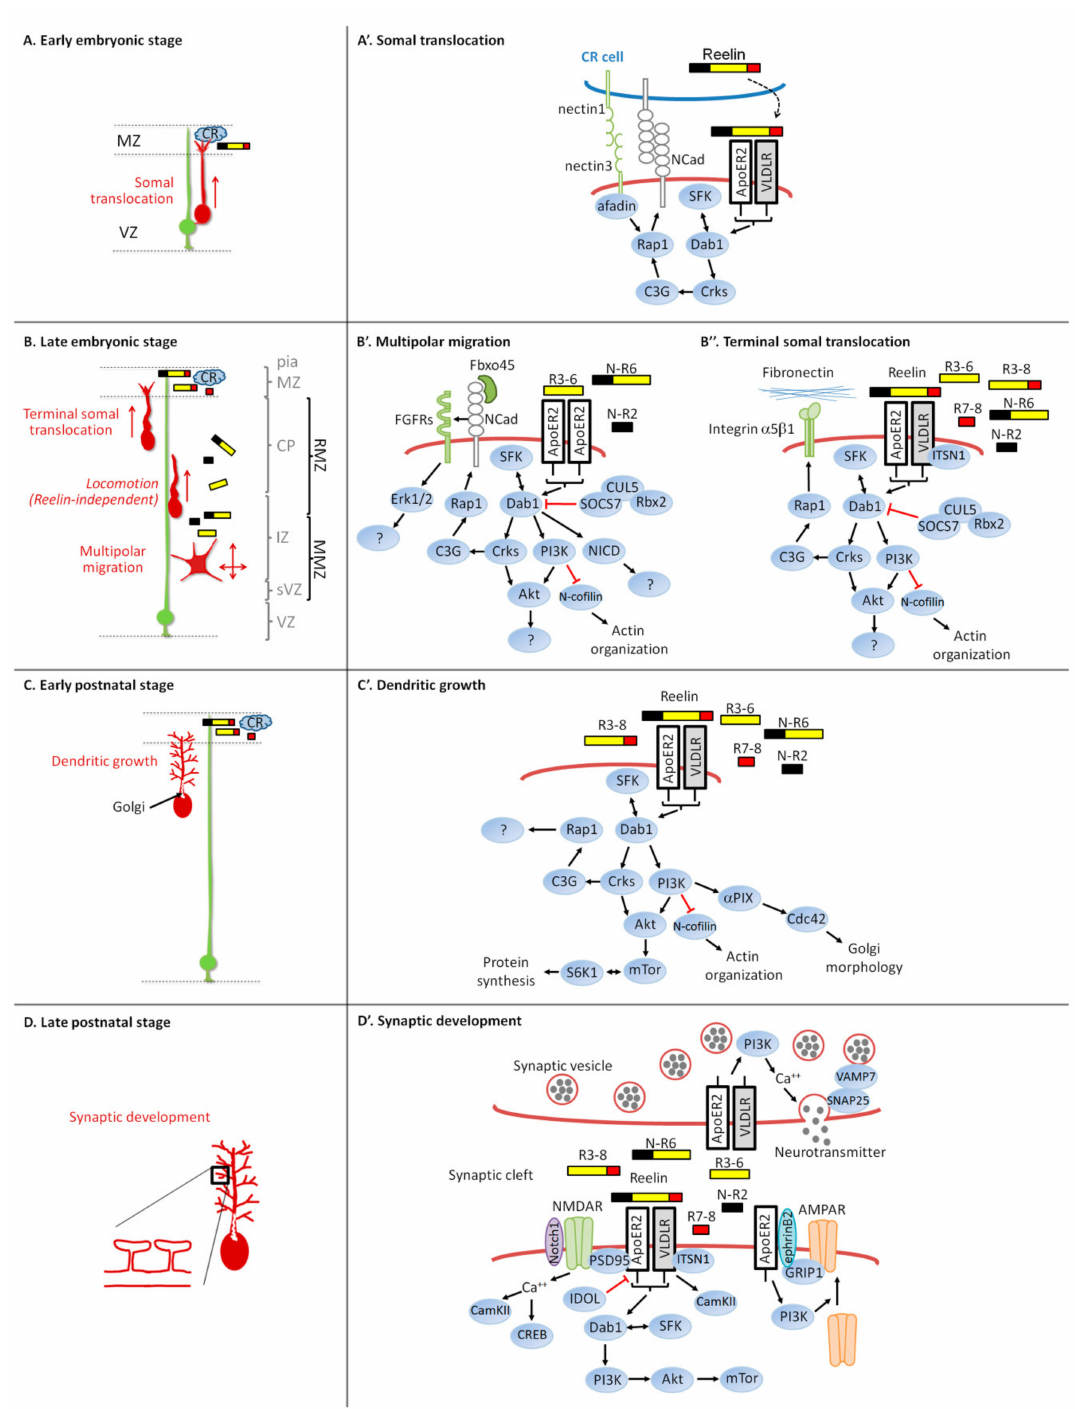
Figure 2. Modeling of the multiple functions of Reelin during migration, dendritic growth and synaptic development and the corresponding signaling pathways: ( A , A’ ). During the early steps of cortical development, early born neurons perform a radial glia-independent somal translocation. Reelin triggers an interaction between Cajal–Retzius cells (CR) and the neuron leading process through N-cadherin and nectins. ( B , B’ , B” ). As the neocortex develops, the cerebral wall increases in thickness. The somal translocation mode of migration is gradually replaced by a radial migration subdivided into four steps: a short bipolar migration during which postmitotic cells move away from the ventricular zone (VZ) (not depicted here), followed by a radial glia-independent multipolar migration. Cells then switch to a radial glia-dependent but Reelin-independent bipolar locomotion and finish their journey with a terminal somal translocation. While the full-length Reelin is produced and mainly located at the marginal